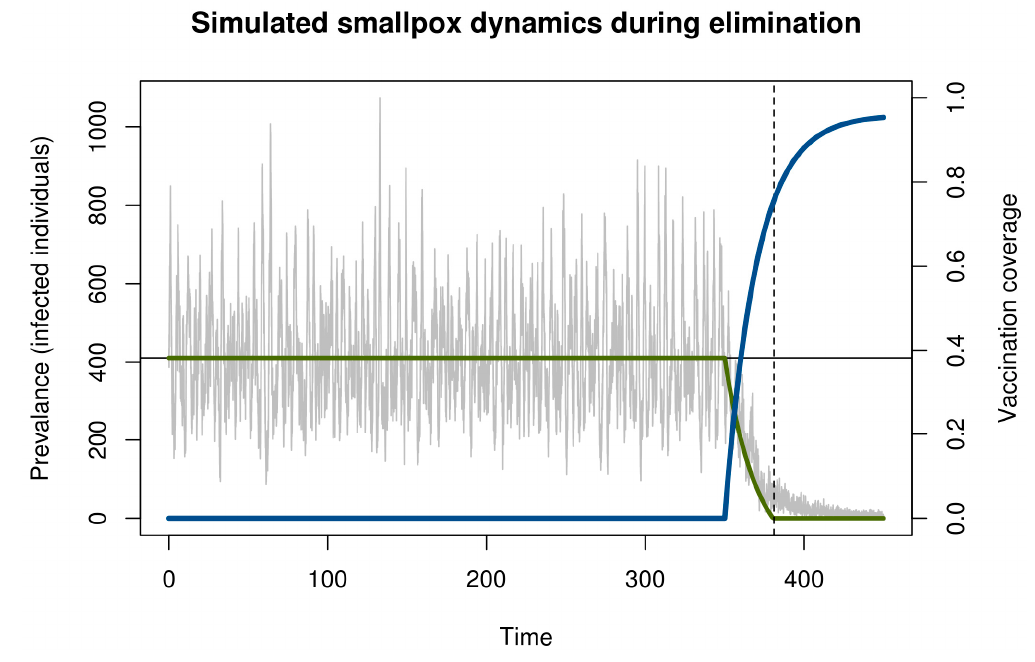
Figure 1. Simulation of smallpox elimination through vaccination. The gray line shows the number of infected individuals over time. The blue line shows vaccination coverage, which approaches a maximum at 0.96. The green line shows the deterministic equilibrium that would be achieved if the vaccination rate was held constant and the time-dependent value. Disease dynamics are given by a stochastic SIR model with states S , I , and R for the number of susceptible, infected, and immune persons, respectively; mean field equations d S /d t = μ ( S + I + R )(1 − ρ ) − β SI /( S + I + R ) – ξ S − μ S, d I/ d t = β SI /( S + I + R ) + ξ S − μ I − γ I, and dR/dt = γ I + μ ( S + I + R )( ρ ) − μ R ; and parameters for transmission β = R 0 ( γ + μ ) ≈ 121.7, recovery γ = 365/12 ≈ 30.4, demography μ = 1/60, externally acquired infection ξ = 0.001, speed of vaccination roll out σ = − 0.05, maximum possible vaccination coverage a = 0.96, and time that vaccination begins s = 100. All rates are in units of years. The function ρ ( t ) = a (1 − exp[ σ ( t − s )]) is the time-dependent vaccination rate. Total population size in this simulation was 100,000 individuals. Solutions were obtained using the adaptive tau-leaping algorithm [25]. Parameters follow Ferguson et al. [26].